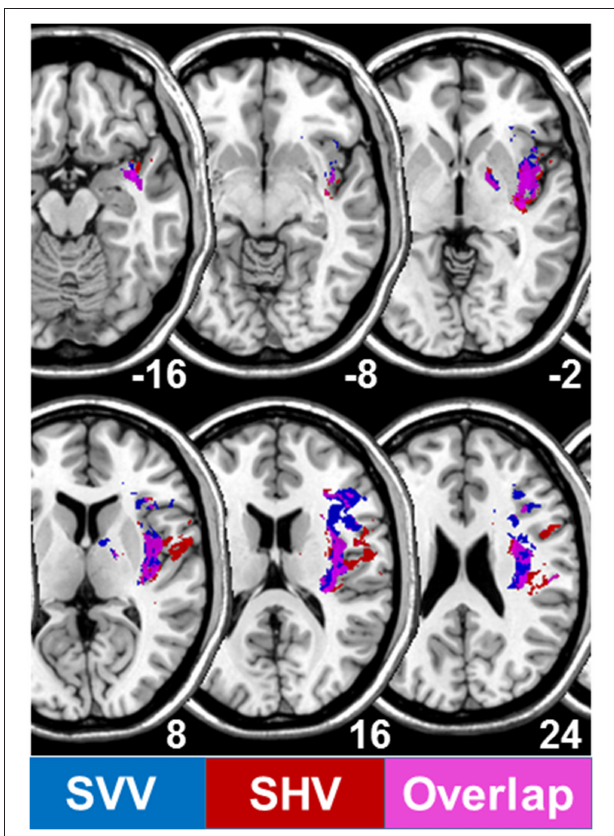
FIGURE 6 | Overlapping lesion plots of 82 patients with an acute unilateral infarction of the right hemisphere. Statistical VLBM analysis comparing the 82 right brain damaged patients with respect to absolute tilts of subjective visual vertical (SVV) and subjective haptic vertical (SHV) ( t -test statistic). Presented are all voxels that survived a correction for multiple comparisons using a 5% permutation rate correction cut off threshold. Lesions associated with SVV tilts are given in dark blue, those associated with SHV tilts in red, overlap of both in